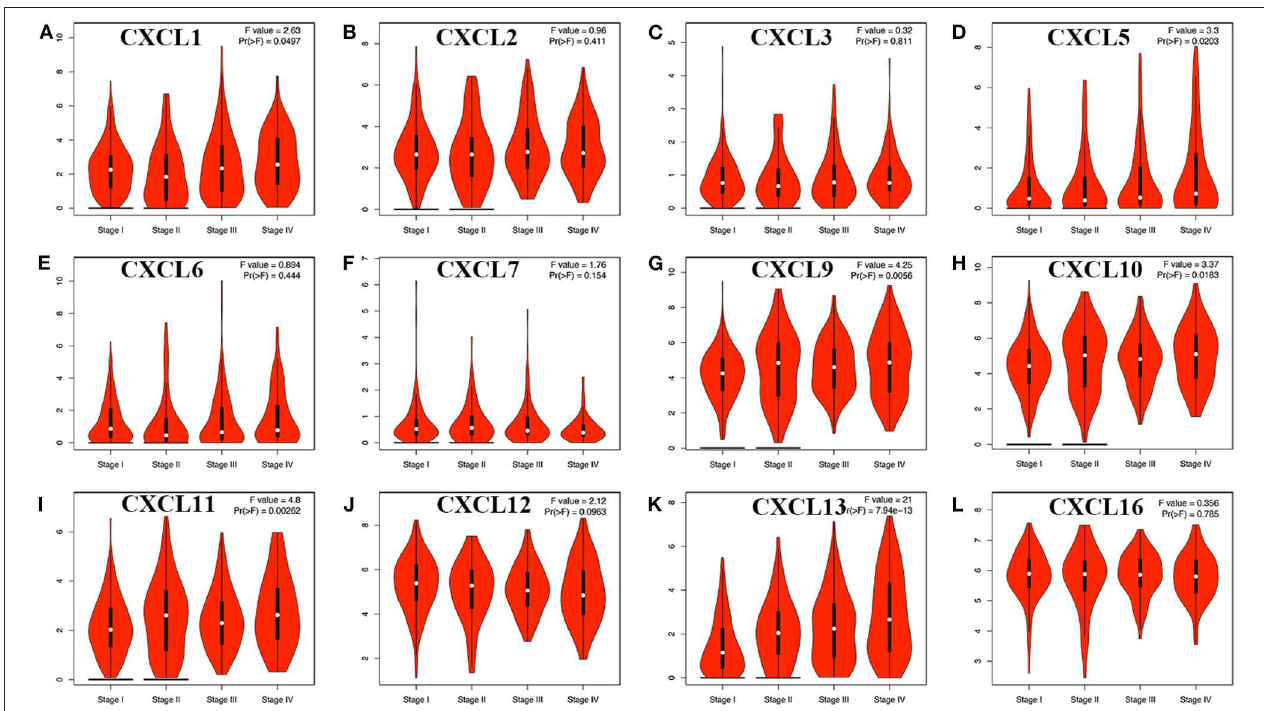
FIGURE 4 | Correlation between different expressed CXC chemokines and the pathological stage of RCC patients (GEPIA). * P < 0.05. (A) CXCL1, (B) CXCL2, (C) CXCL3, (D) CXCL5, (E) CXCL6, (F) CXCL7, (G) CXCL9, (H) CXCL10, (I) CXCL11, (J) CXCL12, (K) CXCL13, and (L) CXCL16.